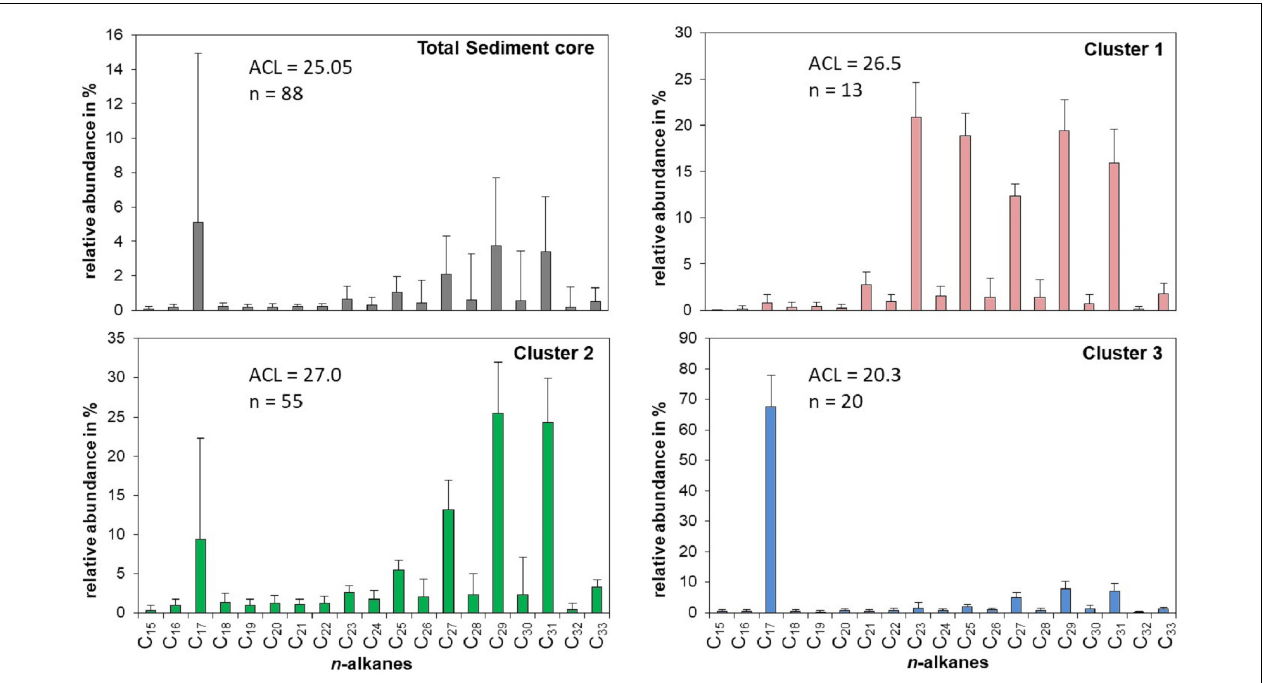
FIGURE 3 | Relative distribution, abundance and ACL [average chain length = (cid:54) (Cn × n)/ (cid:54) Cn)] of n -alkanes for the entire Lake Chatyr Kol sediment core as well as for the three principal